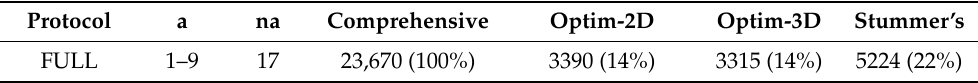
Table 1. Number of data for FULL protocol (percentage of initial array).